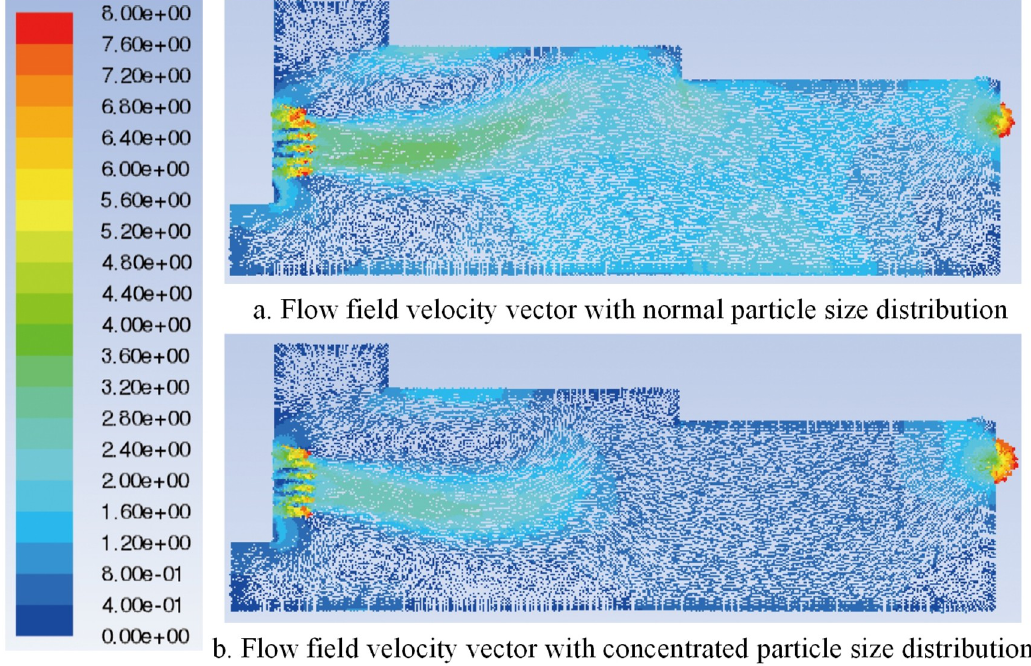
Fig 23. Velocity vector of the airflow field with different particle sizes.